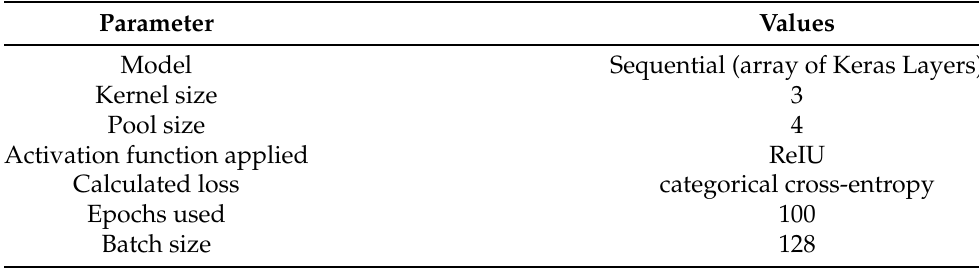
Table A6. Parameters of the convolutional neural networks.